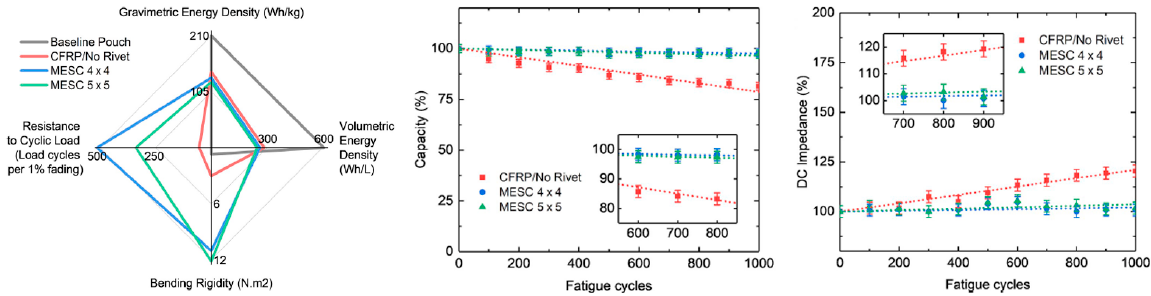
Figure 11. Interlocking rivet energy storage composites performance [27].